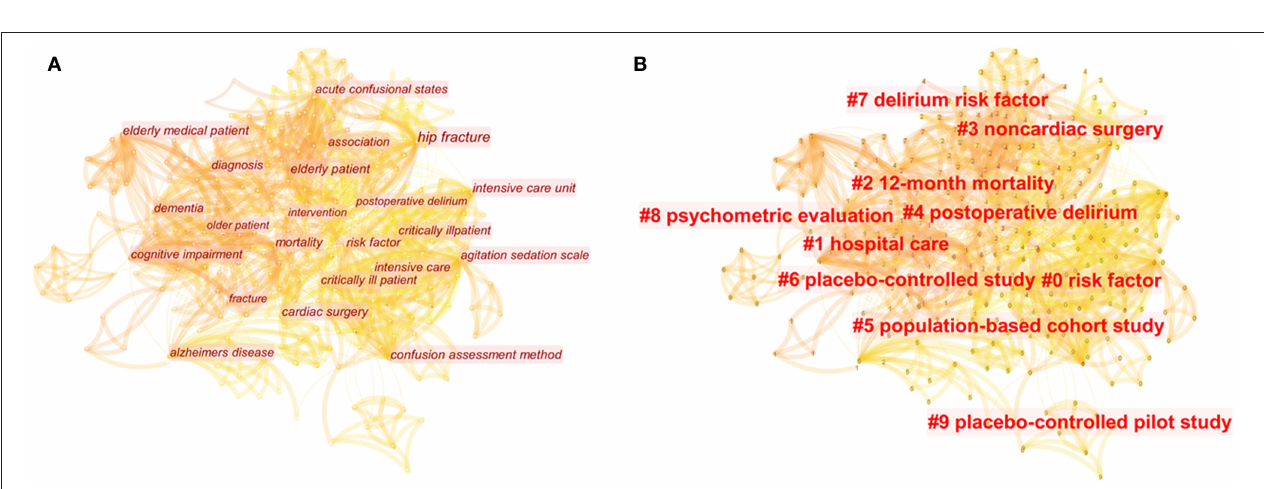
FIGURE 3 | Study types of the 100 most-cited articles in the field of delirium. (A) The article classification. (B) The level of evidence for clinically relevant articles.